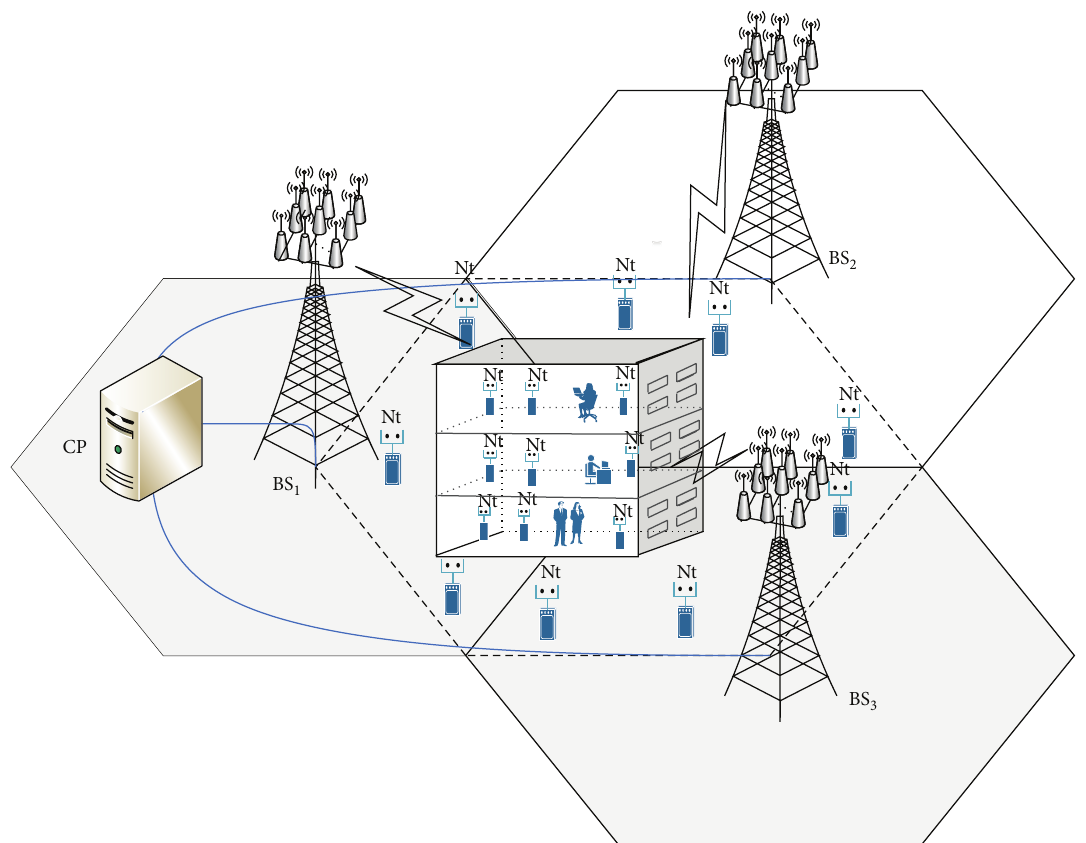
Figure 1: System model of coordinated multicell 3D MIMO network ( 𝐿 = 3 ).